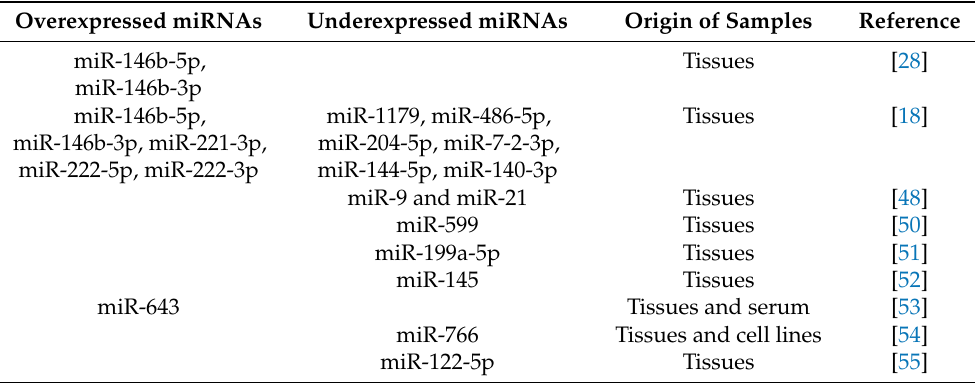
Table 1. The influence of miRNAs on PTC. miRNA Influence Reference Overexpression is a risk factor for PTC recurrence (HR 1.41; miR-221 95%CI 1.14-.95, p = 0.007) Overexpression increases frequency of central neck metastasis miR-222 and lateral neck metastasis ( p < 0.001 and p < 0.001, respectively) Reduced expression of miR-9 and miR-21 increases the risk of miR-9 and PTC recurrence (HR = 1.48; 95% CI 1.24–1.77, p < 0.001; and miR-21